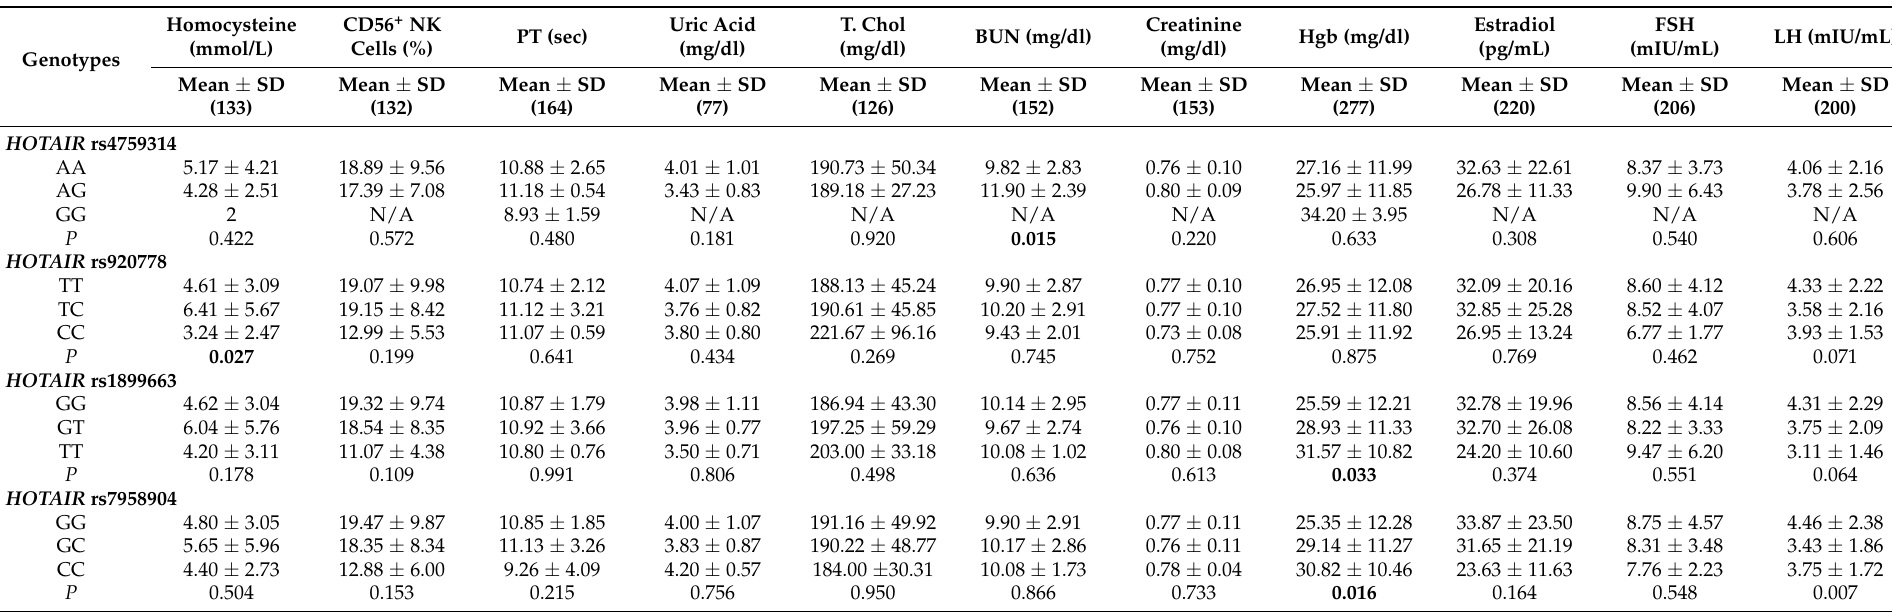
Table 5. Differences in the various clinical parameters according to HOTAIR gene polymorphisms in RIF patients and control